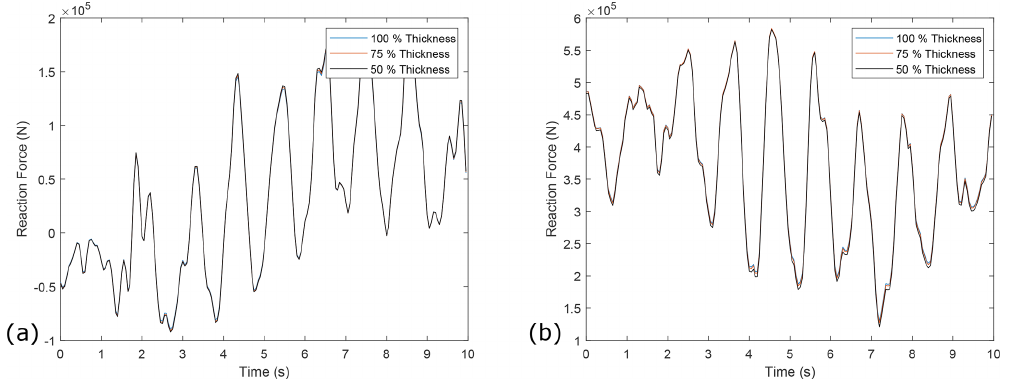
Figure B3. (a) Example time series of reaction force results in the horizontal plane from the FE DTRB model when the shaft thickness is altered. (b) Example time series of reaction force results in the vertical plane from the FE DTRB model when the shaft thickness is